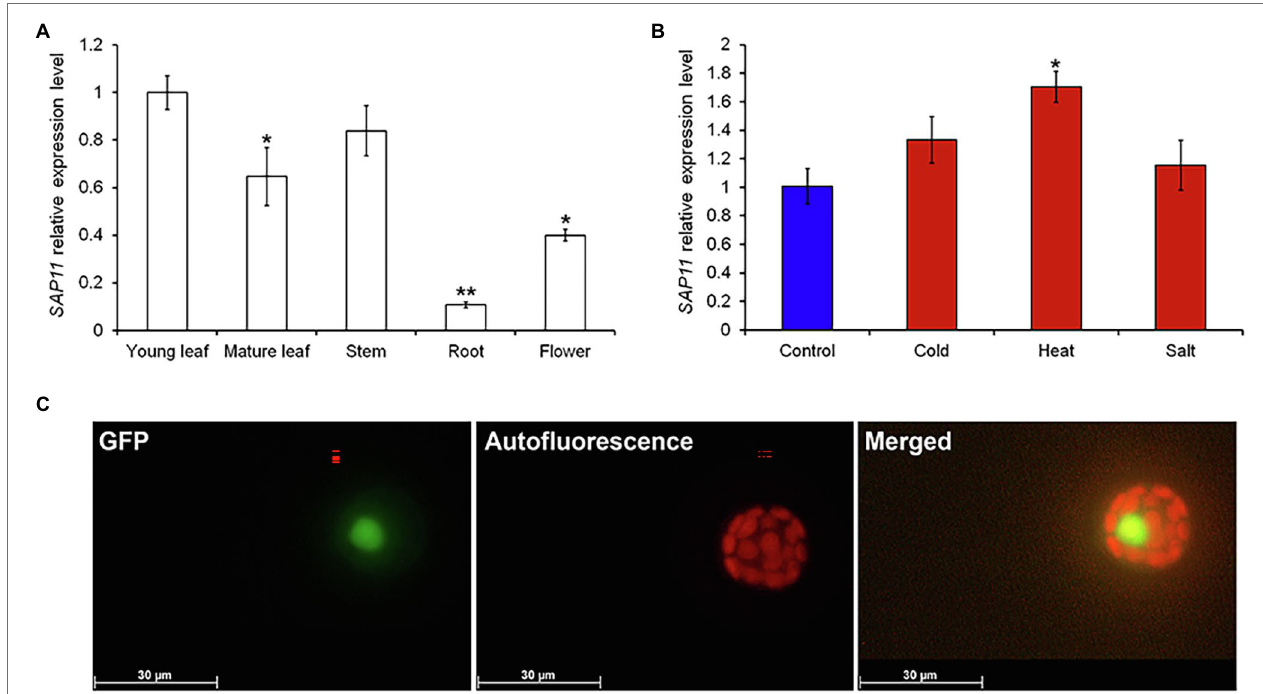
FIGURE 2 | Characterization of PagSAP11 . (A) Expression analysis of PagSAP11 gene in poplar tissues by qRT-PCR: young leaf, mature leaf, stem, root and flower. (B) Expression analysis of PagSAP11 under abiotic stress conditions (cold, heat and salt). The values represent the means ± standard deviations (SDs) of three biological replicates. Asterisks indicate significant differences by student t -test (* p < 0.05, ** p < 0.005). (C) Subcellular localization of PagSAP11 -GFP protein. The green color indicates PagSAP11-GFP expression and red color means autofluorescence. Scale bar = 30 μ